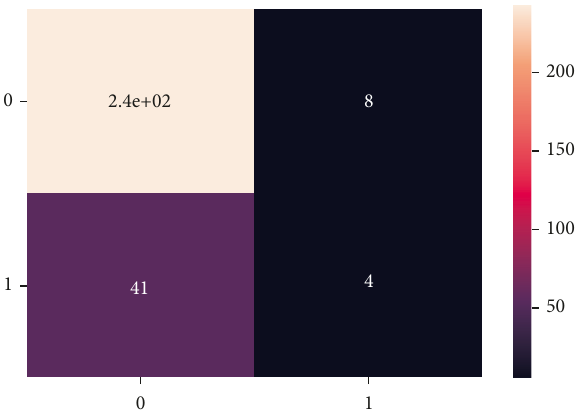
Figure 12: Confusion matrix of decision trees response.